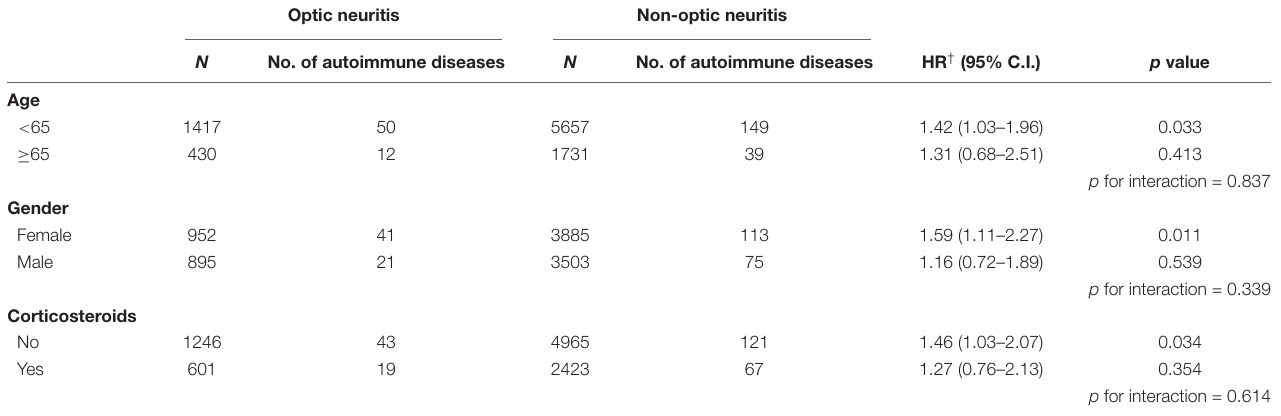
TABLE 4 | Subgroup analysis of the association between optic neuritis and autoimmune